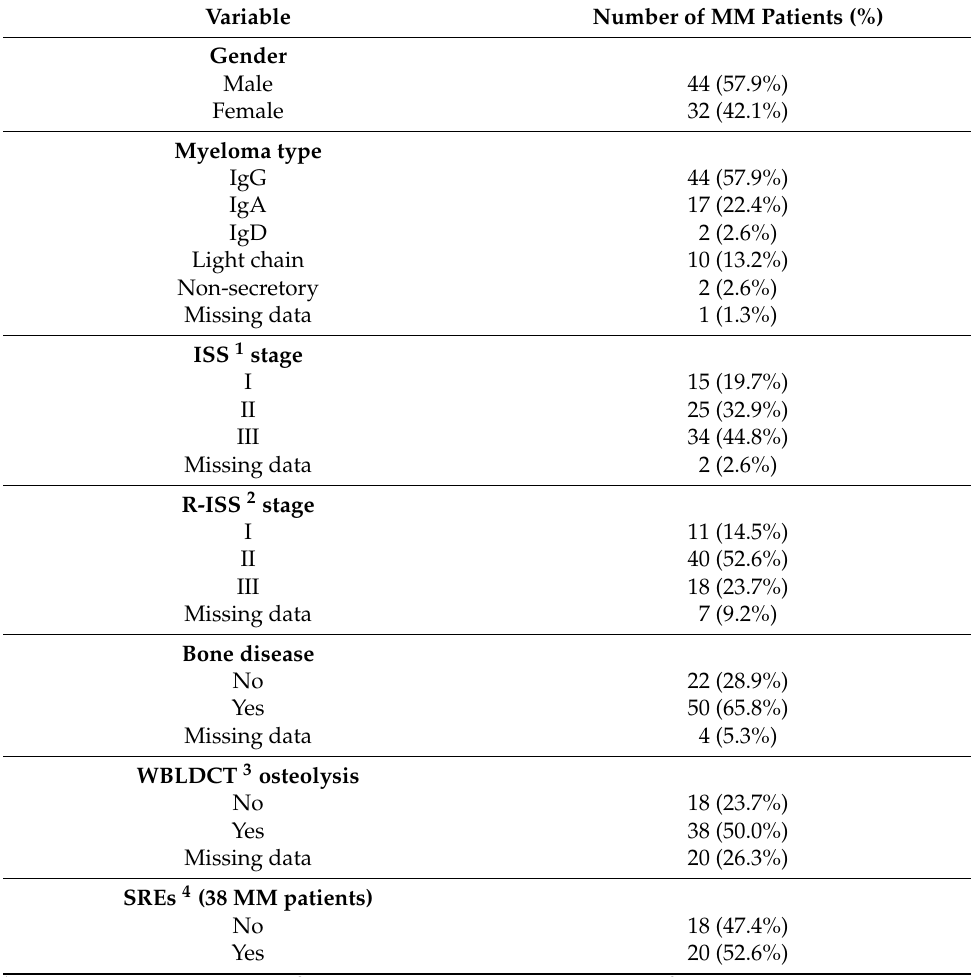
Table 3. Characteristics of the 76 multiple myeloma (MM)